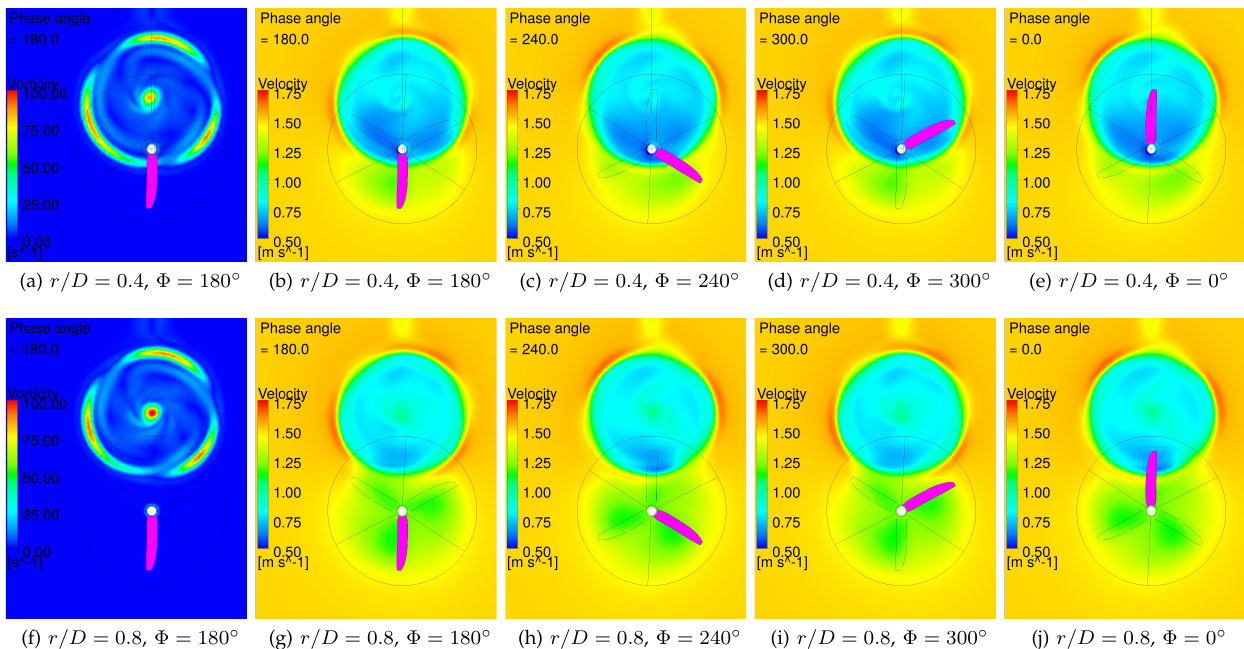
Fig. 13. Instantaneous vorticity and velocity in a plane shortly upstream of turbine T2. Blade 1 (cf. Fig. 12) shown in magenta. Results of simulations r/D = 0 . 4 and r/D = 0 . 8 for different phase angles Φ . Direction of view against flow direction. First turbine (not visible) rotating clockwise, second turbine rotating